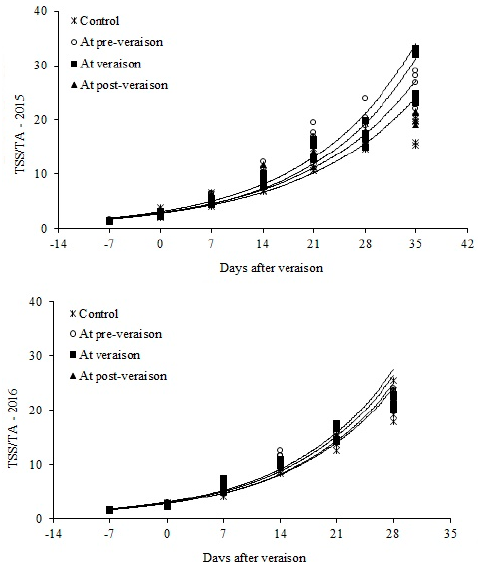
Figure 5. Evolution of maturation index (TSS/TA) of ‘Benitaka’ berries ( Vitis vinifera L.) subjected to ( S)-cis -abscisic acid ( S -ABA 400 mg L − 1 ) at different timings of veraison. A second application of S -ABA 400 mg L − 1 was performed for all treatments 10 days after the first application, except for the control. Data were originated from polynomial regression.